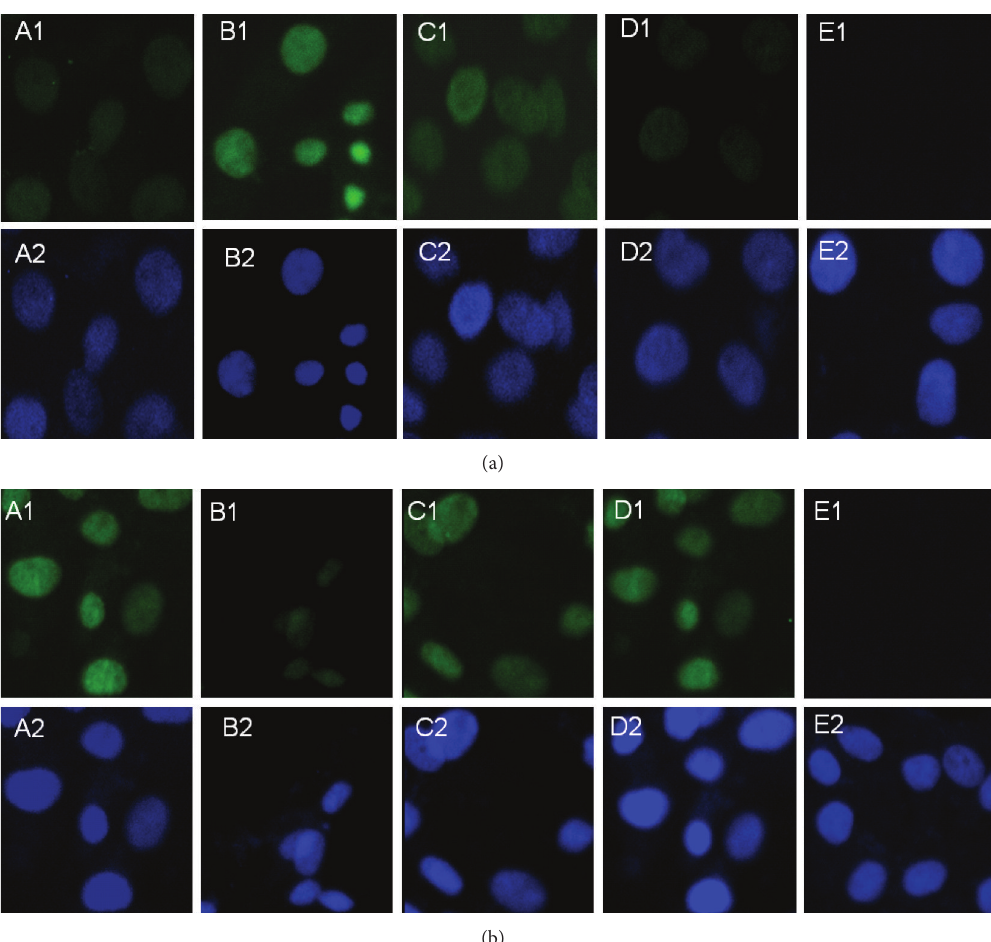
Figure 6: The expression of histone H2A and H2B ubiquitination in GMCs by immunofluorescent staining and laser scanning confocal microscopy applications. A1, NC group, B1, HG3 group, C1, MI group, D1, OP group, E1, negative control, and A2, B2, C2, D2, and E2 represent the corresponding groups of nuclear stains. (a) uH2A protein and (b) uH2B protein. uH2A and uH2B proteins were detected in the nucleus as green fluorescence overlapping with the blue fluorescence emitted by the nuclear stains DAPI. The uH2A protein was not detected in the NC group, but it was prominent in the HG3 group. The protein was strongly detected in the MG132 intervention group, which did not significantly change as a result of high osmotic pressure. The results for the uH2B protein were in contrast to the uH2A results. signaling pathway, which is important in the